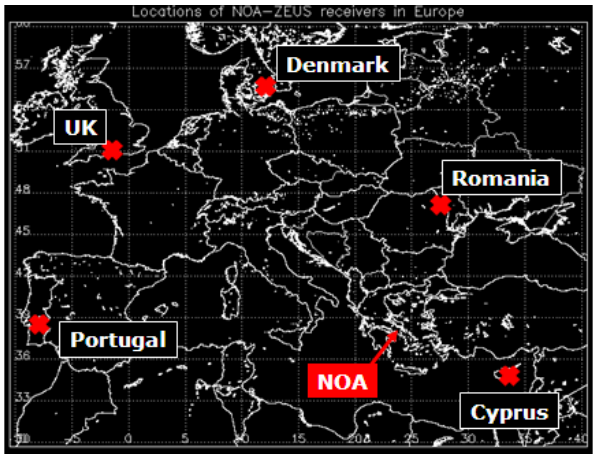
Fig. 1. The ZEUS lightning network.